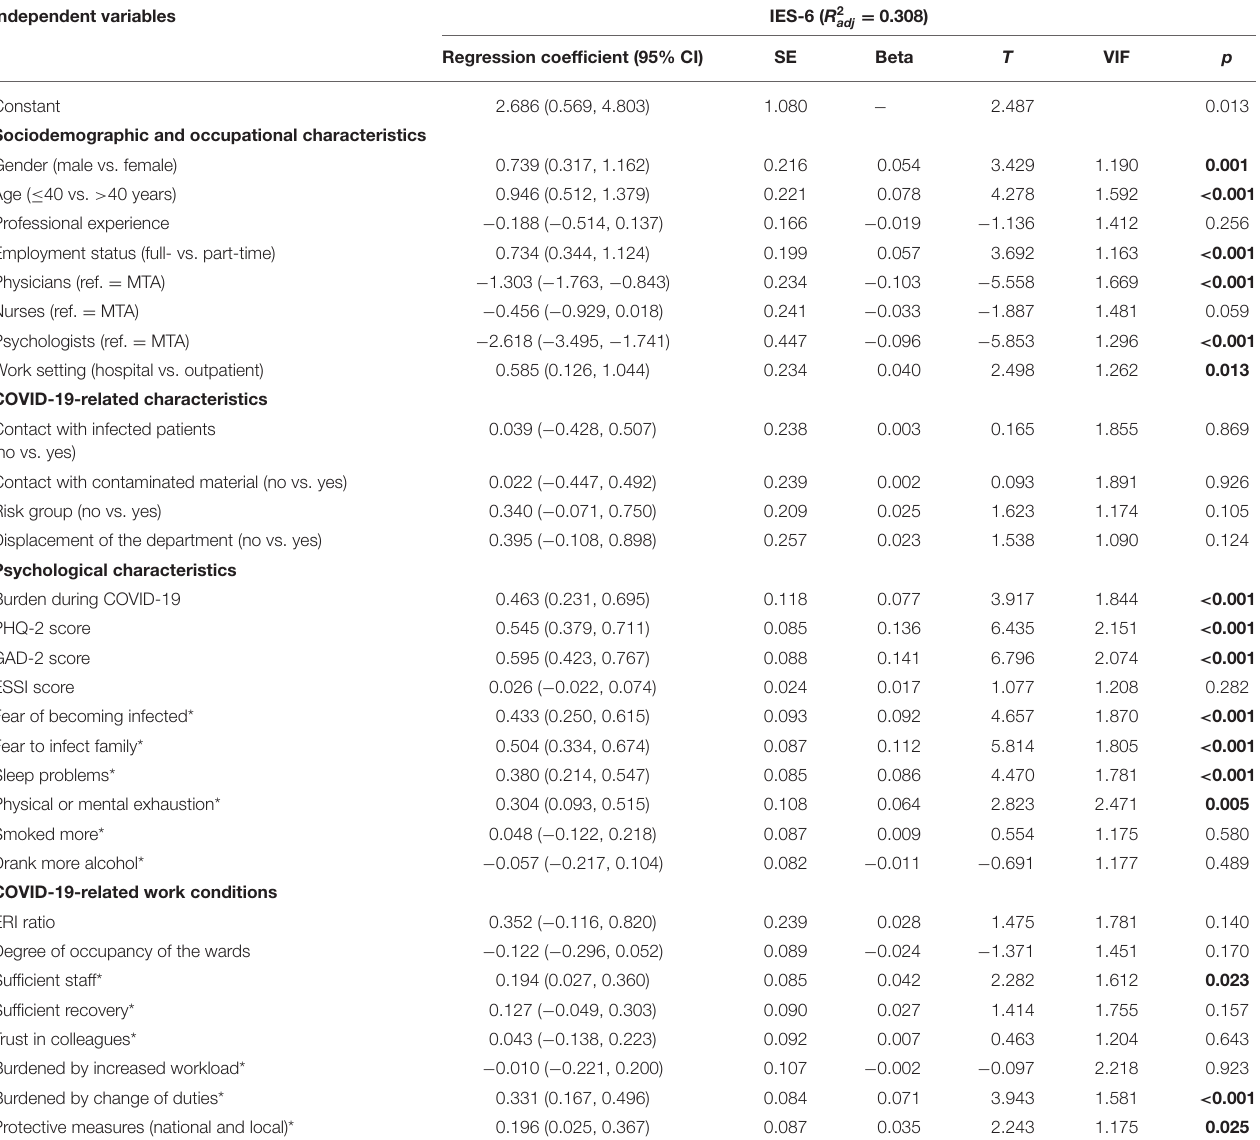
TABLE 5 | Linear regression analysis for severity of PTSD symptoms (IES-6) among the sample of healthcare workers ( N = 3,342). Independent